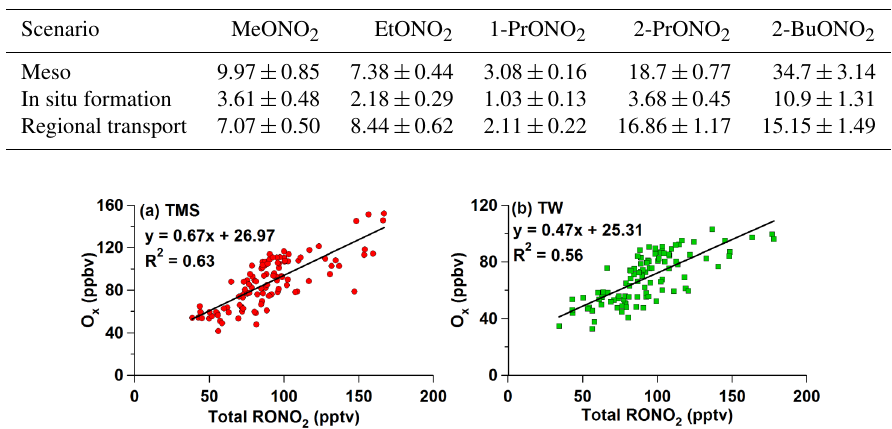
Figure 11. Correlation between O x (O 3 + NO 2 ) and total alkyl nitrates at (a) TMS and (b) TW.